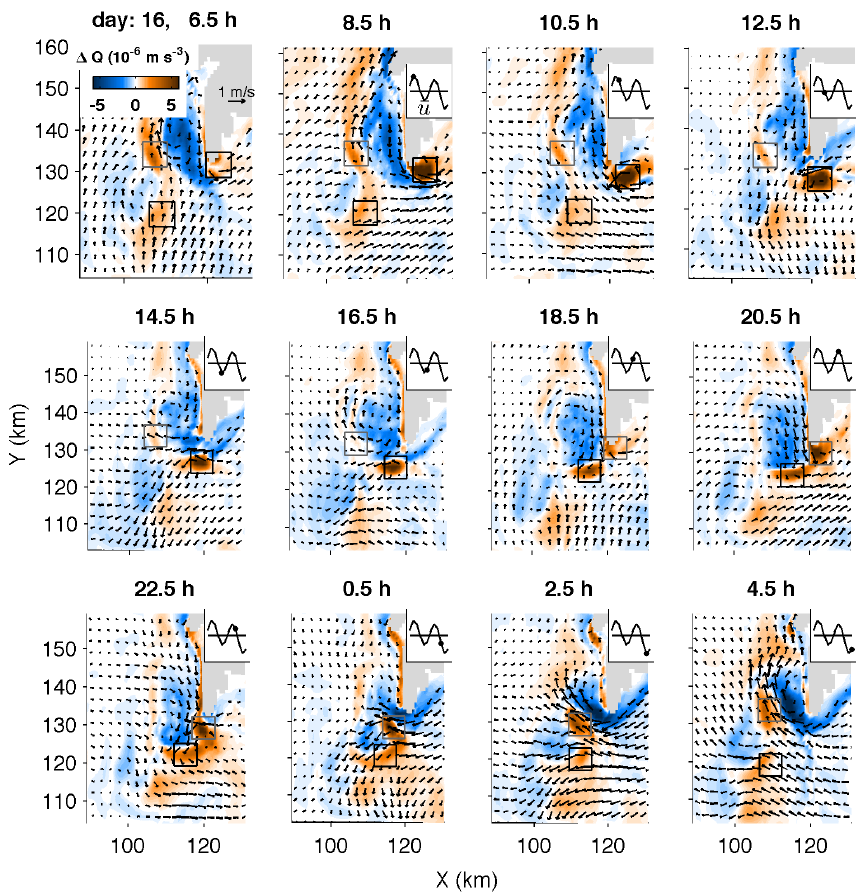
Fig. 5. Tidal evolution of vertically integrated potential vorticity anomaly for 24h of the model run. PV has been integrated as in Fig. 3. Arrows are velocities at 50-m depth; mean tidal flow with the inset panel. Positive vorticity anomalies are identified and tracked with boxes – black boxes coalesce into the mesoscale features south of the cape, gray boxes advect northwards.